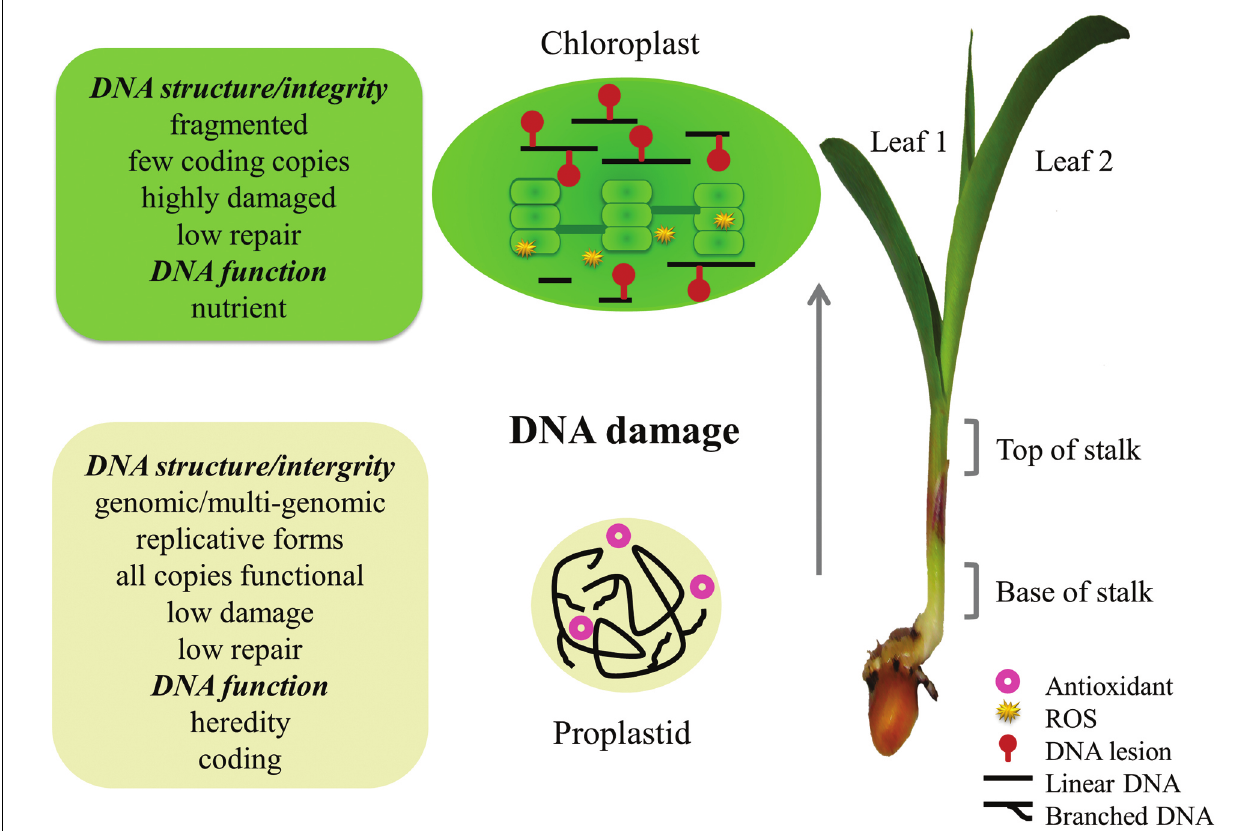
FIGURE 2 | Changes in orgDNA during maize development. Recombination-dependent replication of orgDNA in the basal meristem produces branched, multigenomic chromosomes in proplastids and mitochondria (not depicted). DNA-damaging oxidative stress is minimized, requiring little repair, by maintaining hypoxia, antioxidants, and no ROS-generating photosynthesis or respiration. Early in leaf development, orgDNA damage occurs due to ROS generated in photosynthesis, respiration, and oxidation of pigments and lipids. Later, when the damage level exceeds the repair capacity, orgDNA is fragmented and no longer functions in coding or heredity, mitochondria switch from respiration to photorespiration, and DNA copy number declines faster for mitochondria than for chloroplasts. (Reprinted from Kumar et al., 2014).